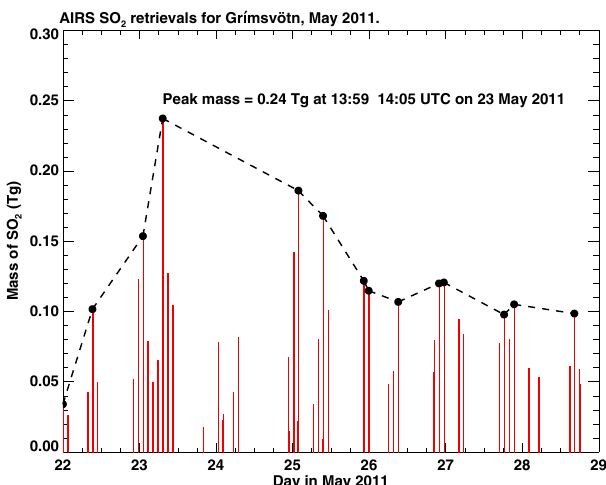
Figure 7. AIRS UTLS SO 2 mass loading (Tg) as a function of time for 22–29 May 2011. The dashed line shows the locus of maximum mass loadings – since AIRS sometimes has incomplete coverage of the whole plume, a true estimate of the maximum SO 2 mass is difficult.